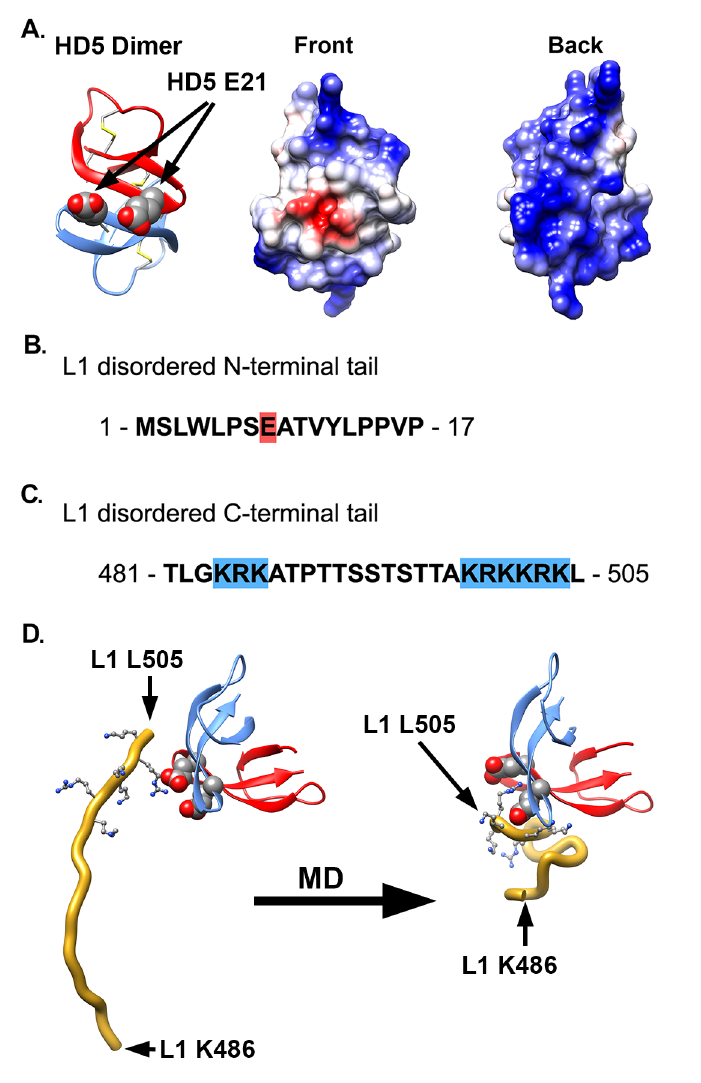
Figure 4. Proposed interaction between HD5 dimer and L1 C-terminal tail. (A) Ribbon and Coulombic surface representations of an HD5 dimer (PDB: 1ZMP, chains A and C). Disulfide bonds are depicted in stick representation and E21 residues in space-filling representation. The 2 E21 residues are next to each other in the dimer and form a negatively charged patch (red) on the Coulombic surface of a predominantly positively charged Coulombic surface. (B) Sequence of the longest disordered L1 N-terminal tail (aa 1-17) in the near-atomic resolution cryoEM-based HPV16 structure (PDB: 5KEP). (C) Sequence of the longest disordered L1 C-terminal tail (aa 481-505). In panels B and C charged residues are indicated with red (negative) or blue (positive) highlights. (D) MD-derived model of the interaction between an HD5 dimer and the L1 C-terminal tail (aa 486-505, gold ribbon). Both the starting and ending coordinates are shown. The negatively charged residues of the HD5 dimer (space-filling representation) form favorable electrostat- ic interactions with positively charged residues in the L1 C-terminal tail (499-KRKKRK-504, ball and stick